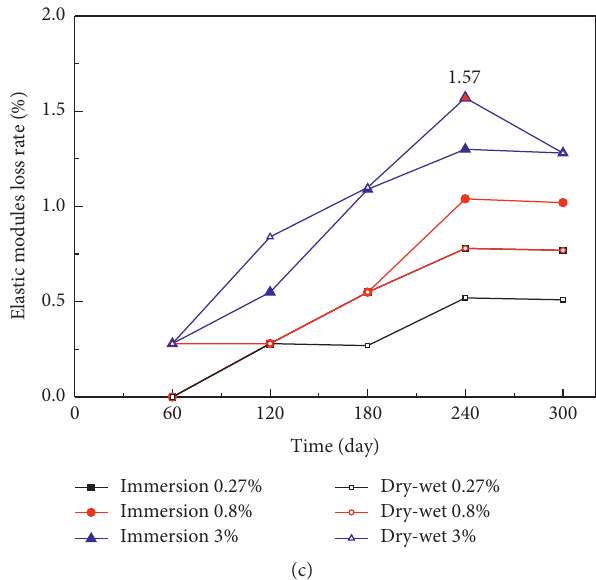
Figure 2: Loss rate of mechanical properties of concrete.